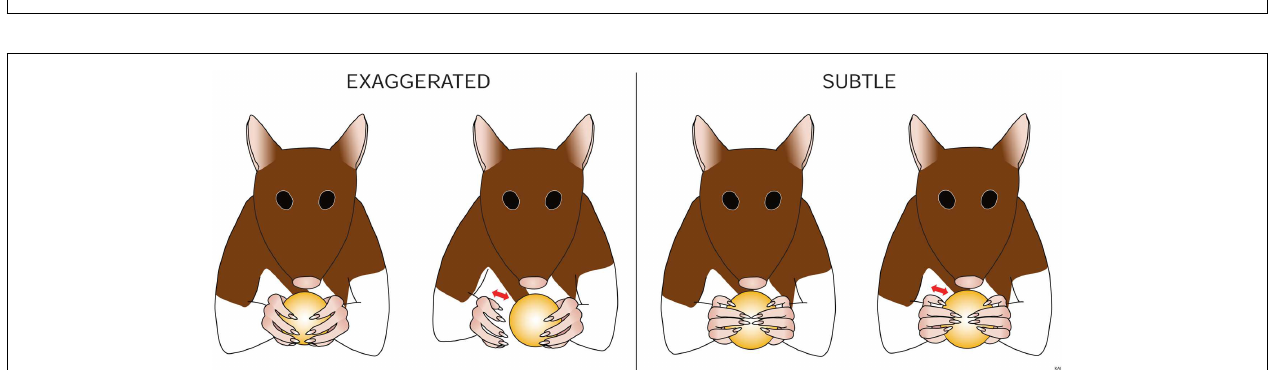
FIGURE 6 |Amendment: predominant forepaw position .The rat is assessed for the most common position (more than 50% of the time) assumed by the digits. Scored as either (A) clubbed flexed fixed – the digits are flexed and held in a fist with joint angles of about 90 ° . (B) Extended, non-adaptable – One or more of the digits are partially extended with joint angles between 180 ° and 160 ° ; in addition, these digits DO NOT CONFORM